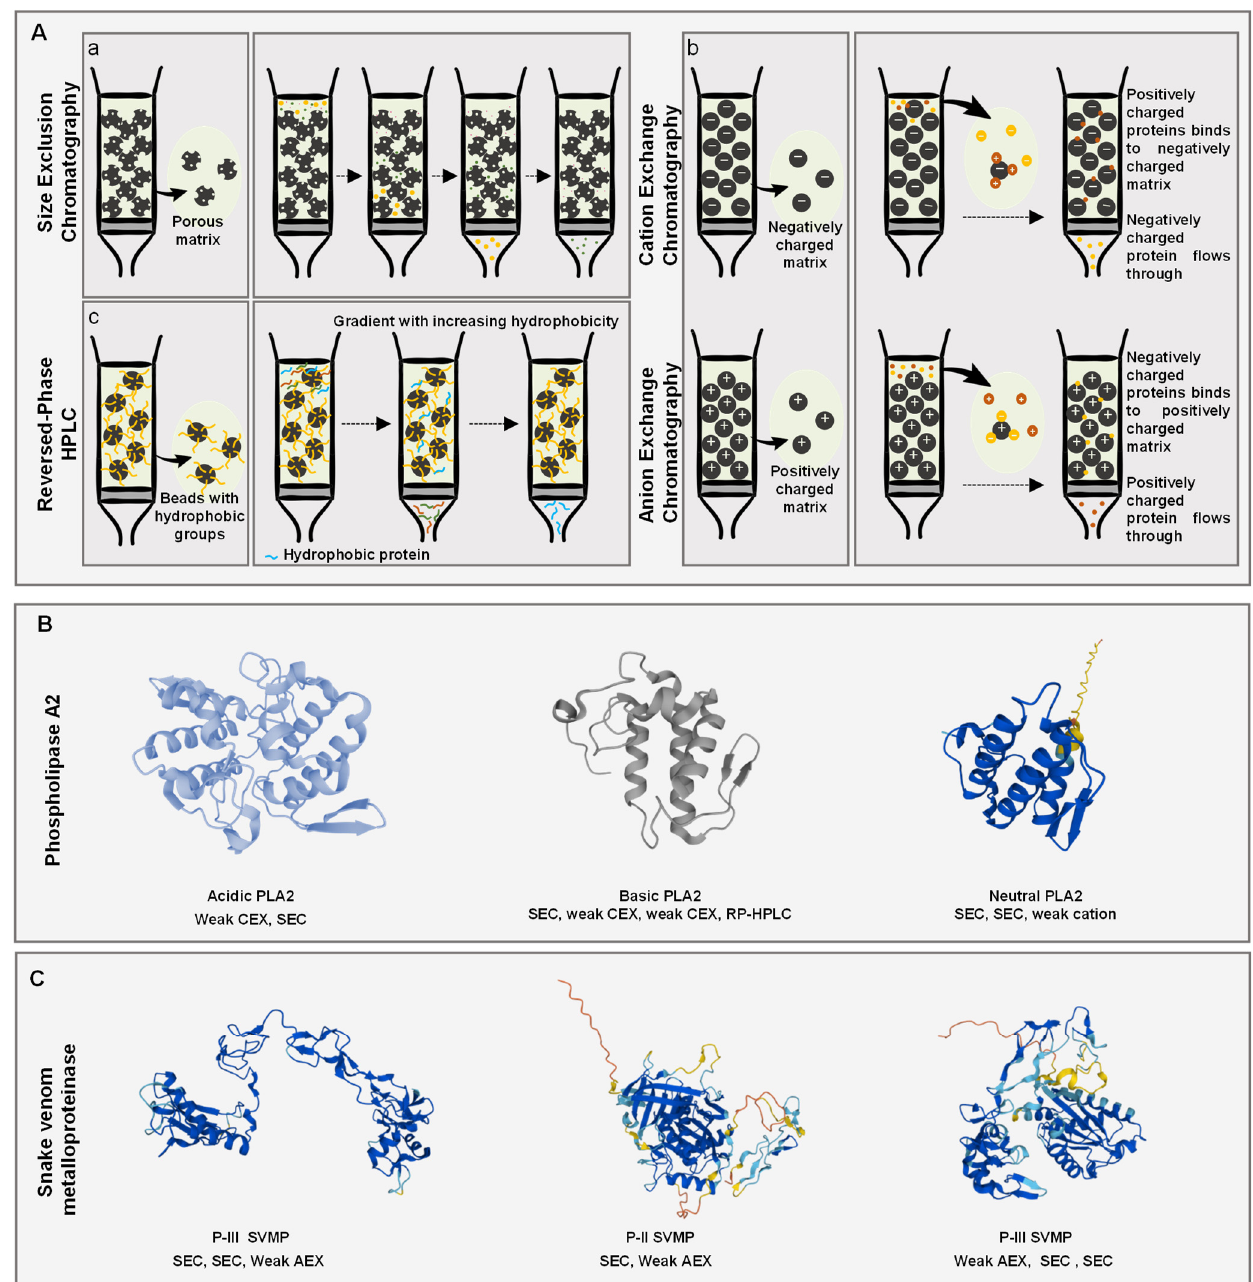
Figure 1. ( A ) Schematic representation of the following chromatographic techniques. ( Aa ) Porous matrix of size exclusion chromatography (i.e., dextran, dextran–agarose, or dextran–polyacrylamide) and the separation process using an isocratic elution buffer (i.e., 0.01 to 0.1 M of ammonium acetate, ammonium bicarbonate or sodium acetate). ( Ab ) Anion-exchange chromatography (AEX) positively charged matrix (i.e., quaternary amine or diethylaminoethanol) and cation-exchange chromatography (CEX), negatively charged matrix (i.e., sulfonic acid or carboxymethyl) and their corresponding separation process using linear or stepwise elution gradients (i.e., sodium chloride or ammonium bicarbonate can be used as elution buffers). ( Ac ) Hydrophobic matrix of reversed-